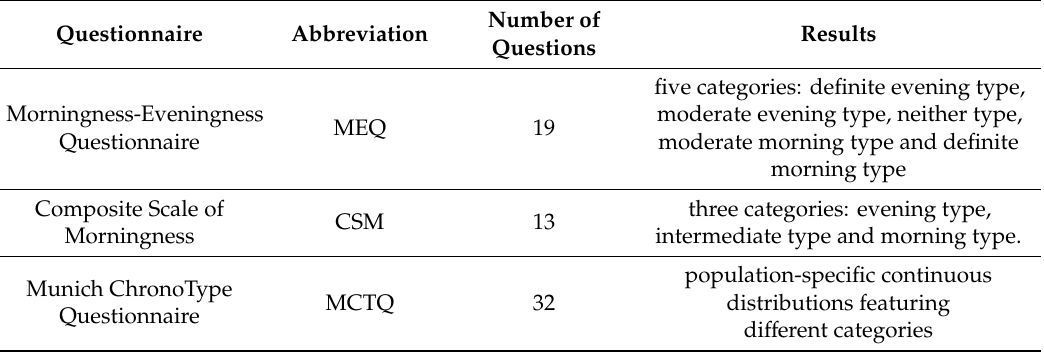
Table 1. Most commonly used questionnaires utilized for chronotype